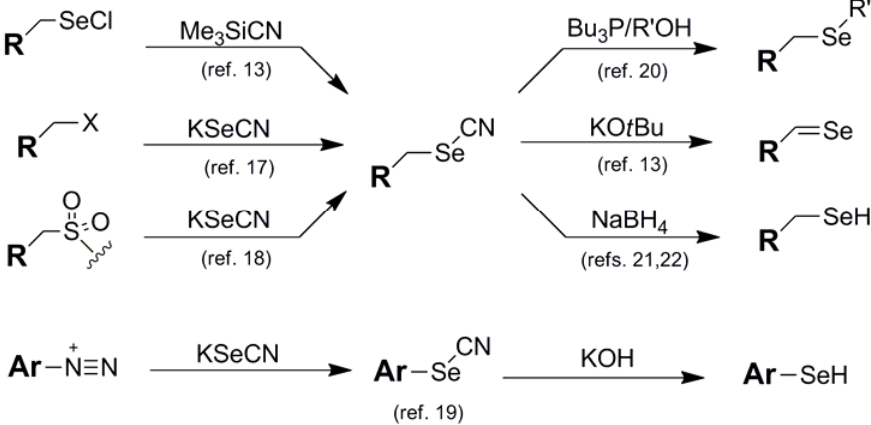
Figure 4. Synthetic routes into Cyanate protection schemes and their deprotection pathways to release their corresponding free selenol and other selenium-containing functions.